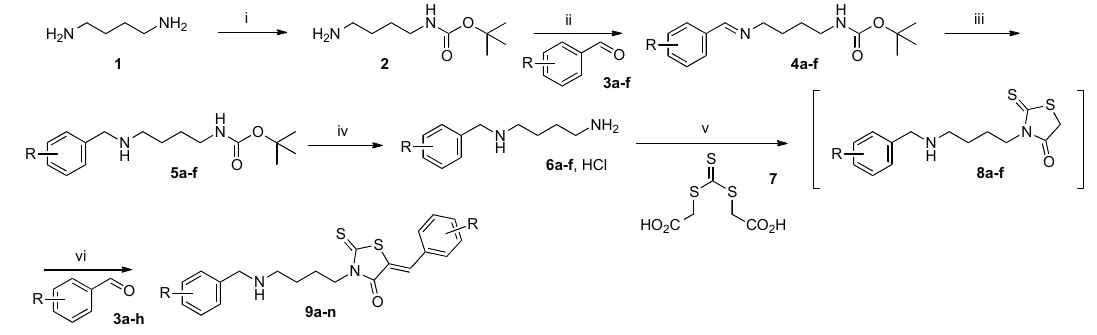
Scheme 1. Route used for the preparation of